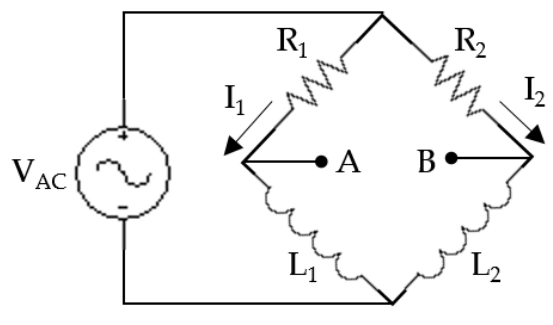
( c ) Figure 4. A two-layer balanced coil array architecture. ( a ) Balanced coil array in the first; ( b ) balanced coil array in the second layer; and ( c ) overlapped layers to cover the entire plane. One layer does not cover the entire plane, and the coils are arranged across one by one in the ( N × M ) grid structure. These two layers are overlapped to cover the entire plane. If N × M coils are placed in one plane to cover the entire plane, the LC resonance circuit is formed by the parasitic parallel capacitance produced between adjacent coils. Thus, when a MO is inserted, the inductance of the coil at the position where the MO is placed changes, and a series of current change occurs in neighboring coils, leading to the change of current flowing through the all coils. This phenomenon attenuates the effect of comparing the signal difference using the balanced coil. Thus, like the proposed structure, the coils are arranged one by one to minimize the effect of the surrounding coils If a MO is inserted on top of X 2 , the inductance of X 2 is reduced by the MO as shown in Equation (7). Thus, the balance of X 2 and X M −1 is broken. When you detect which coil pair is out of balance, you know the presence of a metal foreign object. In a balanced coil array, if the area of the rectangular loop coil is narrowed and the number of coils arranged is increased, the size of the detectable foreign object decreases and the place resolution increases. However, the magnetic flux passing through the cross-section of the coil also decreases, which reduces the amount of induced current. In addition, since systems such as wireless charging for vehicles use high-power AC signals, noise generated in the system is large, making it more difficult to detect the induced current change. Therefore, it is common to add an amplifier in order to improve the foreign object detection sensitivity [12]. However, there is a problem that even noise is amplified in this case. Therefore, we propose a balanced coil array with a serial-resonance Maxwell bridge circuit that can detect a small change of inductance. 2.3. Serial-Resonance Maxwell Bridge Circuit The Maxwell bridge as shown in Figure 5 is generally used to measure an unknown inductance